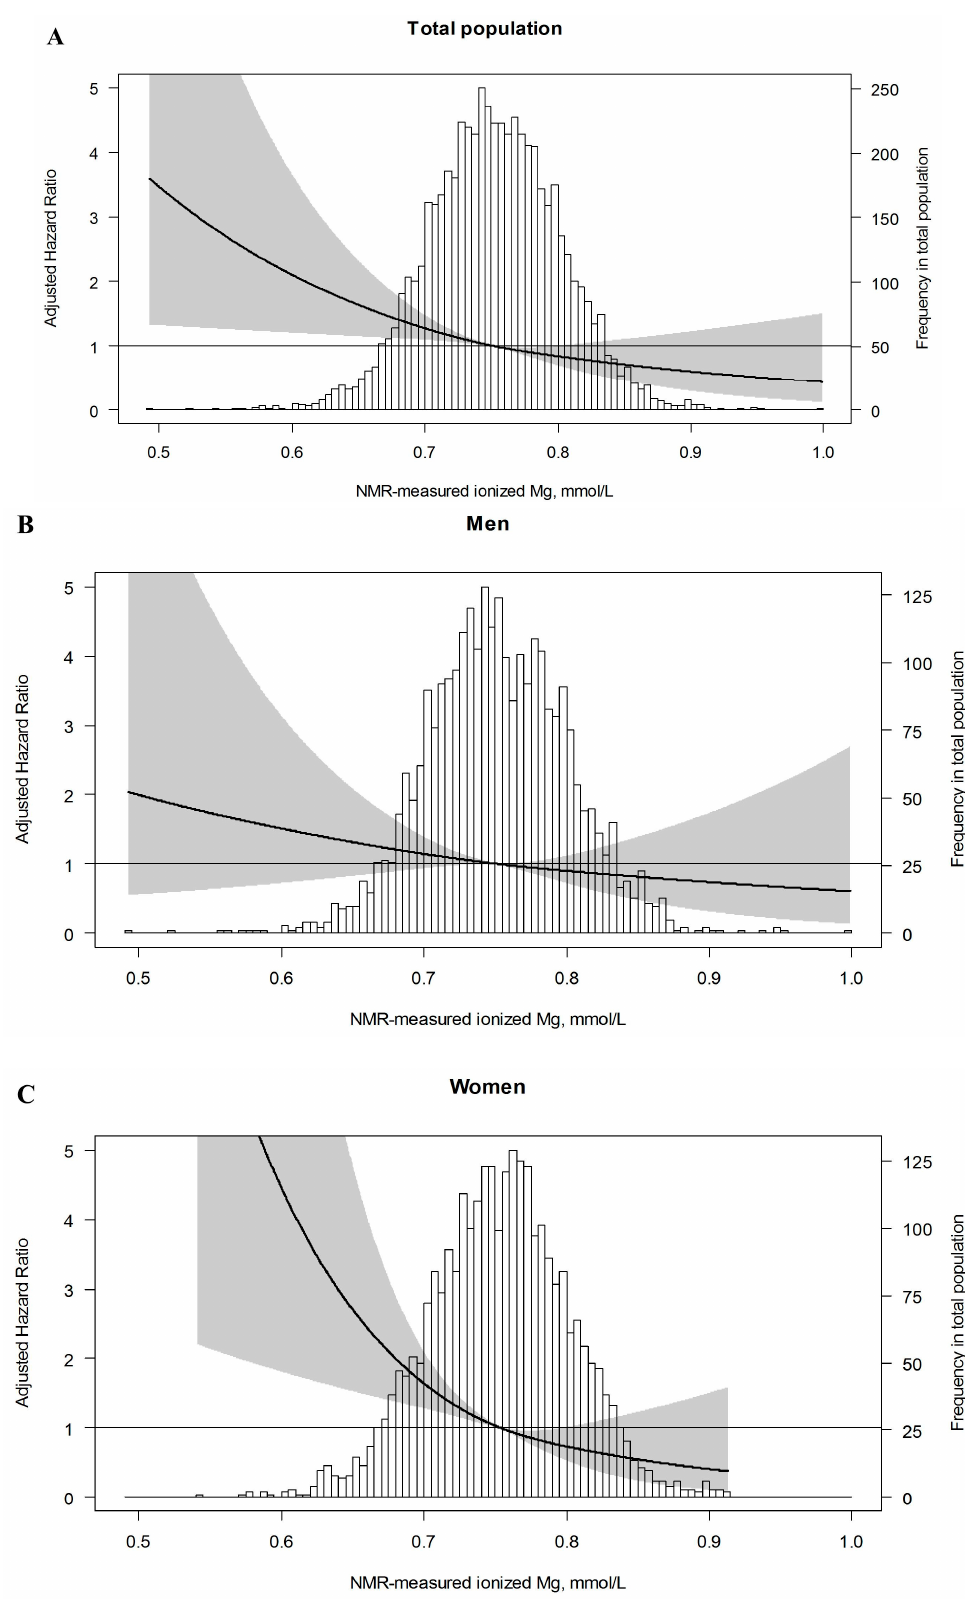
Figure 4. Association between NMR-measured Mg and the risk of developing T2DM. Data were fit by a restricted cubic spline with 3 knots and were adjusted for age ( A–C ) and sex ( A ).